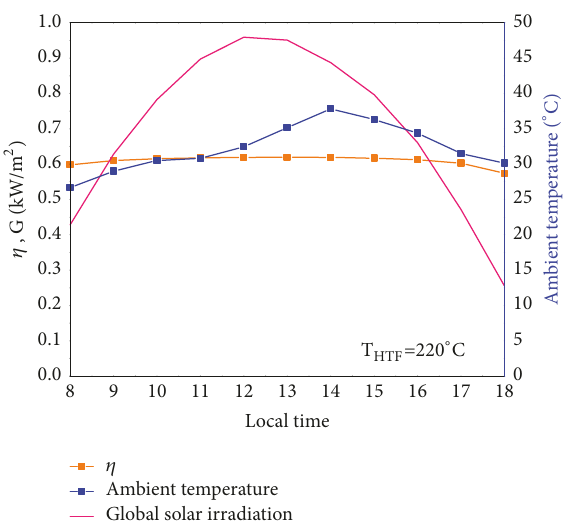
Figure 9: Collector efficiency versus ambient temperatureand solar radiation for a fixed temperature 𝑇 𝐻𝑇𝐹 = 220 ∘ C and climate conditions of Figure 7.